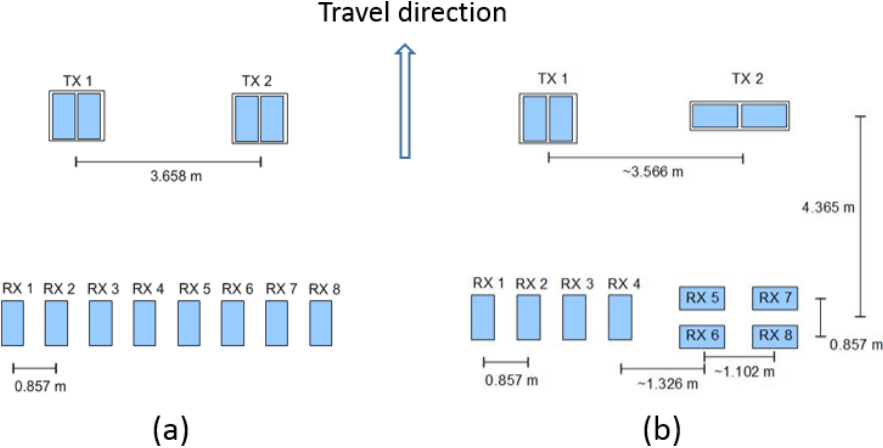
Figure 1. Antenna configurations: (a) non-polarimetric HH polarization setup; (b) quad-polarimetric setup.